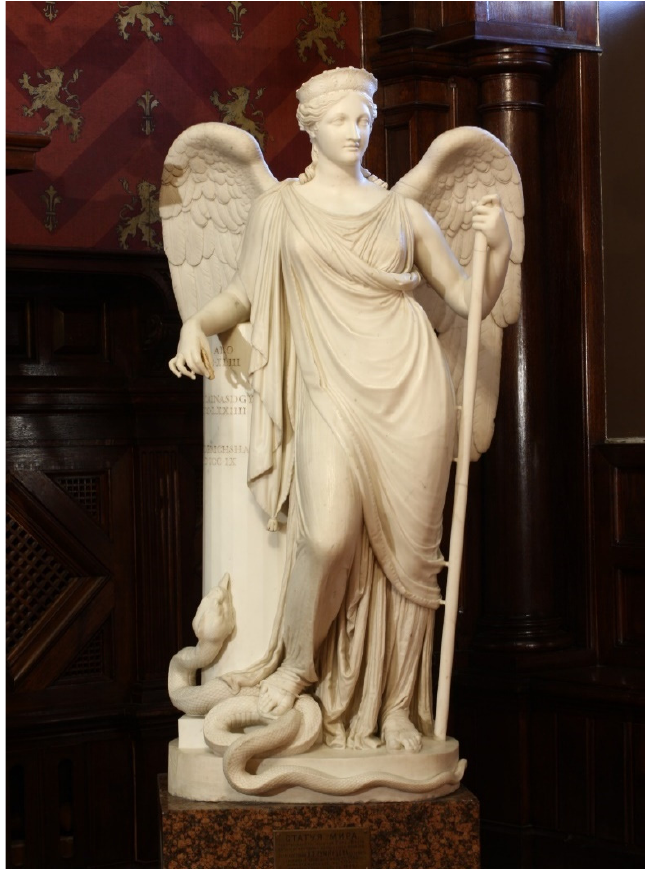
Figure 16. Antonio Canova. A Statue of Peace , 1814. Bohdan and Varvara Khanenko National Museum of Arts, Kyiv.